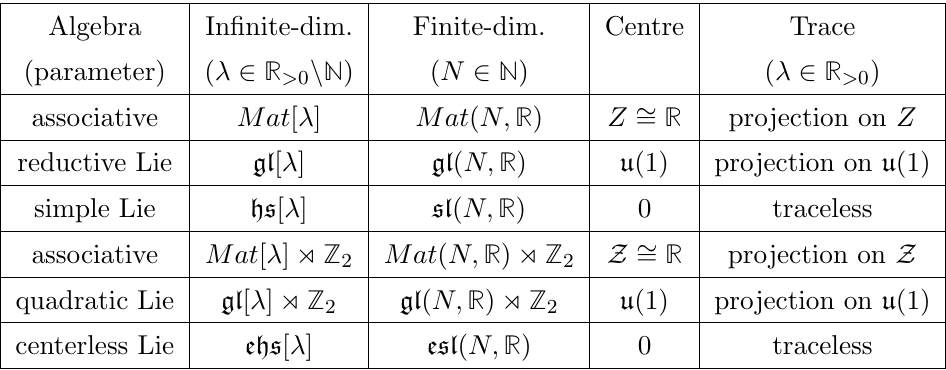
Table 1 . Relevant